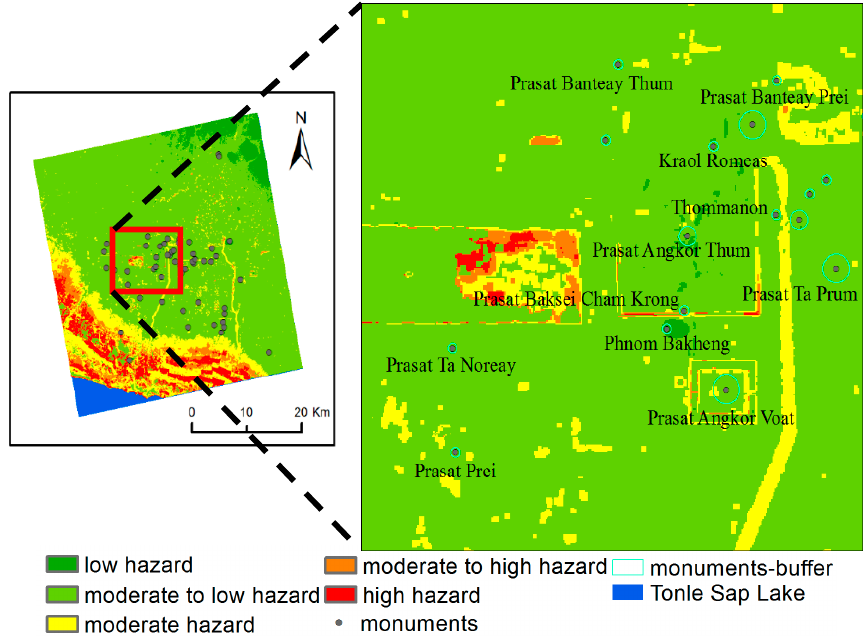
Figure 8. Maps showing overlap of the components of the site and those in the buffer zone.